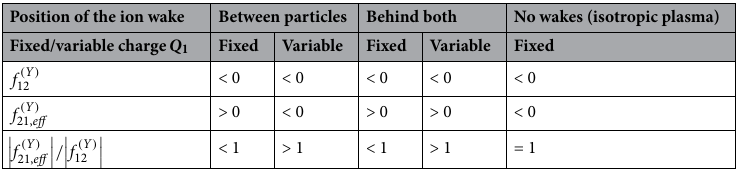
Table 1. Comparison of the derivatives of interaction forces at different positions of the maximum of the ion wake (i.e., between particles or behind both) and different models of the lower particle charge (fixed or variable). The calculations were performed for the point-wake model 21 of the particle interaction with the